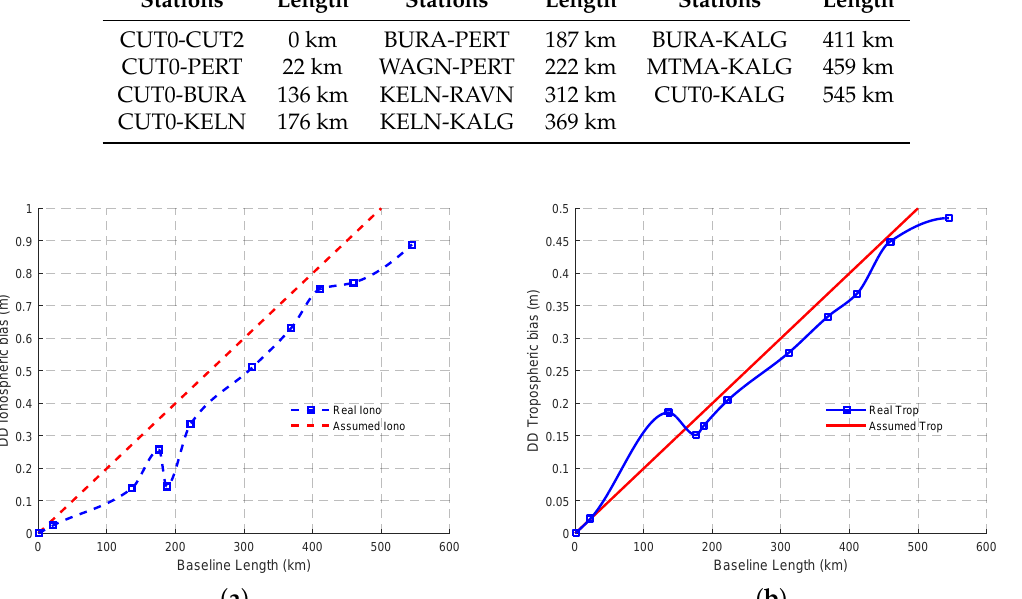
Figure 8. The variation trend of DD ionospheric bias and DD tropospheric bias updates with the baseline length. ( a ) The ionospheric bias; ( b ) The tropospheric